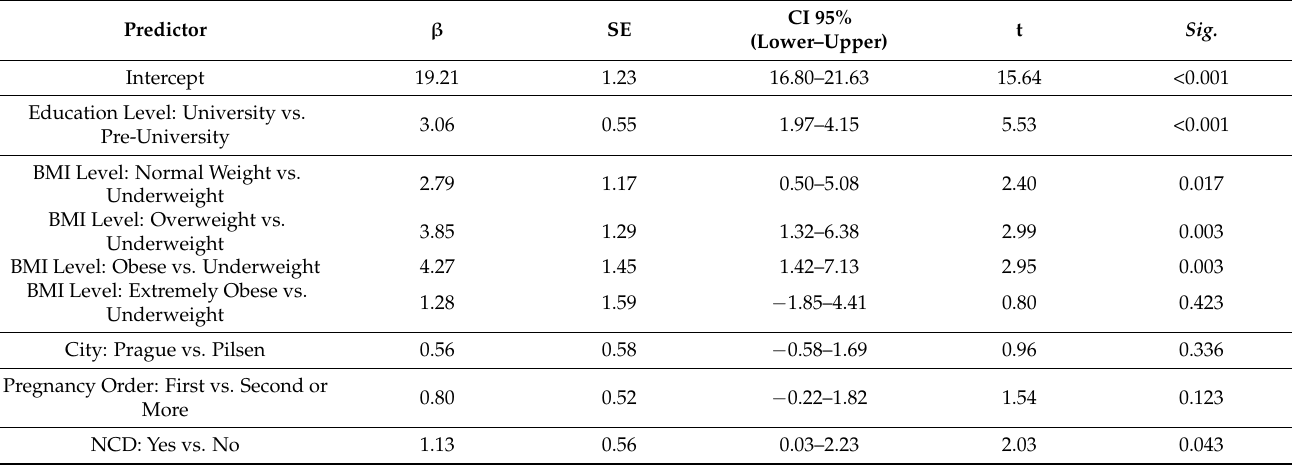
Table 5. Linear regression of nutritional health knowledge score among pregnant women participat- ing in the nutritional health survey, April–May 2022 ( n = 401).